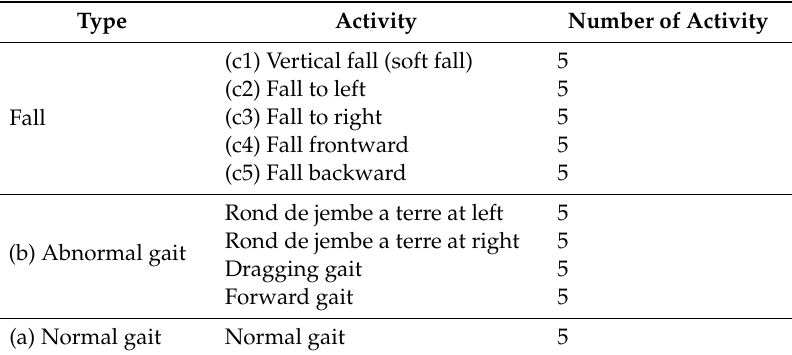
Table 1. Statistical information on simulated behavior of rehabilitation training performed by each